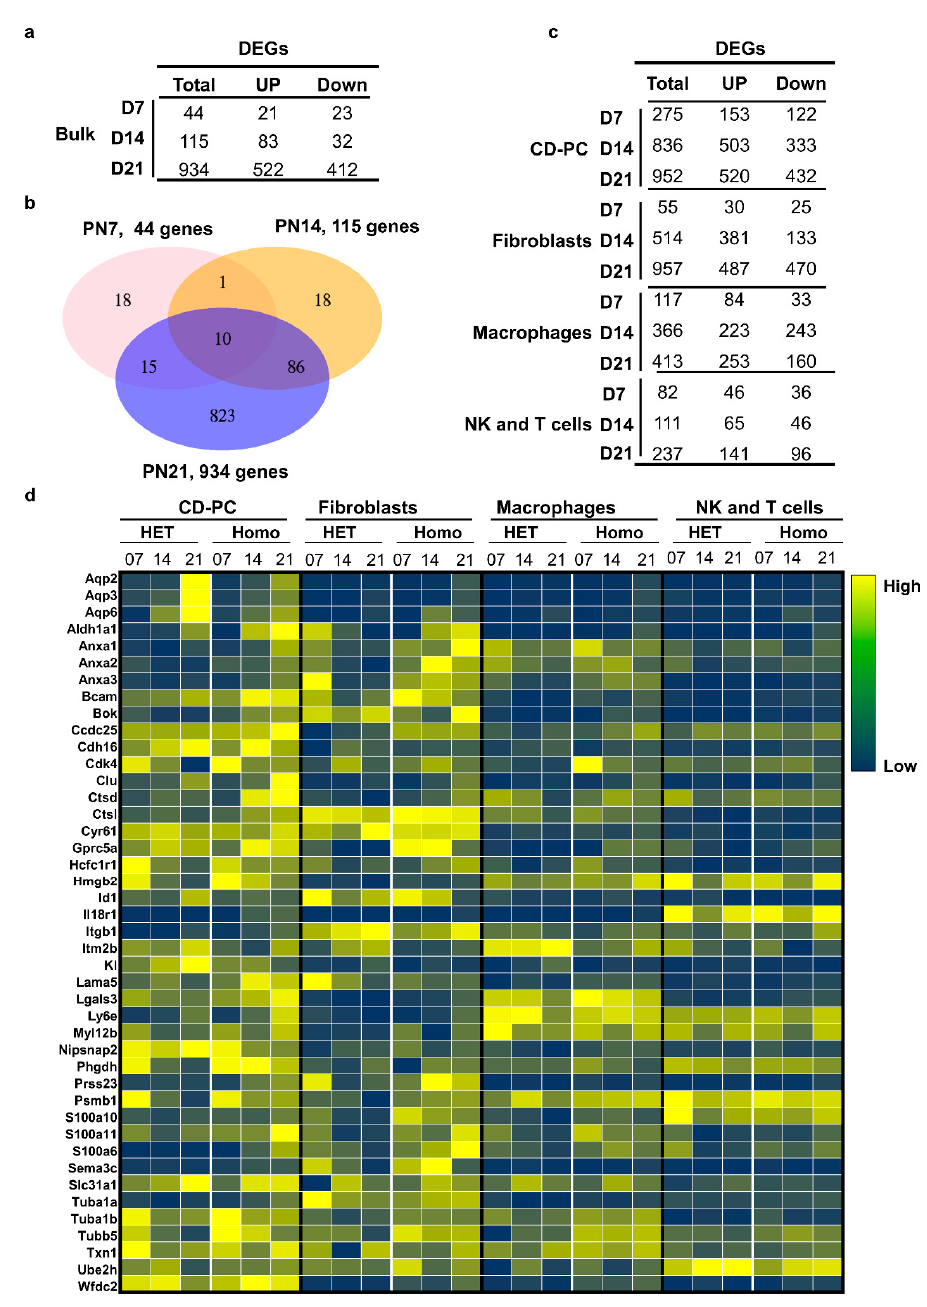
Figure 5. Single-cell resolution identified higher gene expression viability within Pkd1 heterozygous and homozygous knockout kidneys than bulk analysis. ( a ) Graph showing DEG counts identified from bulk RNA analysis for each stage (log2 (mean gene expression in Pkd1 HOMO/mean gene expression in Pkd1 HET) > 0.25, Poisson mixed-model FDR < 0.05). ( b ) Venn diagram showing the overlaps of differentially expressed genes at the three stages. ( c ) DEG counts identified by single-cell RNA-seq analysis for each cell type (log2 (mean gene expression in Pkd1 HOMO/mean gene expression in Pkd1 HET) > 0.25, Poisson mixed-model FDR < 0.05). ( d ) Heatmap